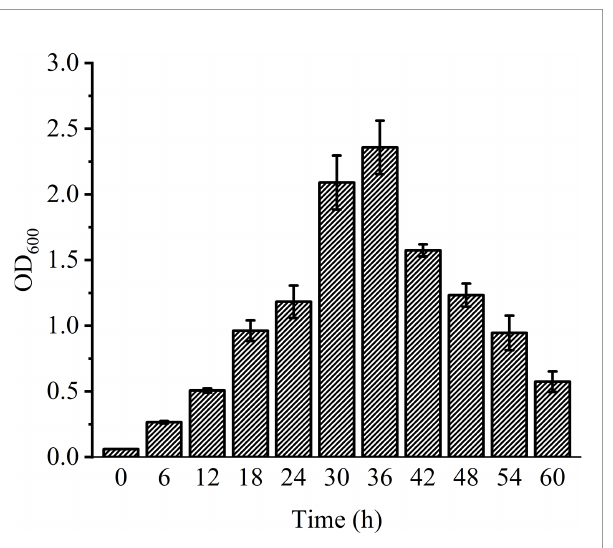
FIGURE 4 | SEM results of planktonic and bio fi lm cells of V. parahaemolyticus . (A) planktonic cells. (B) bio fi